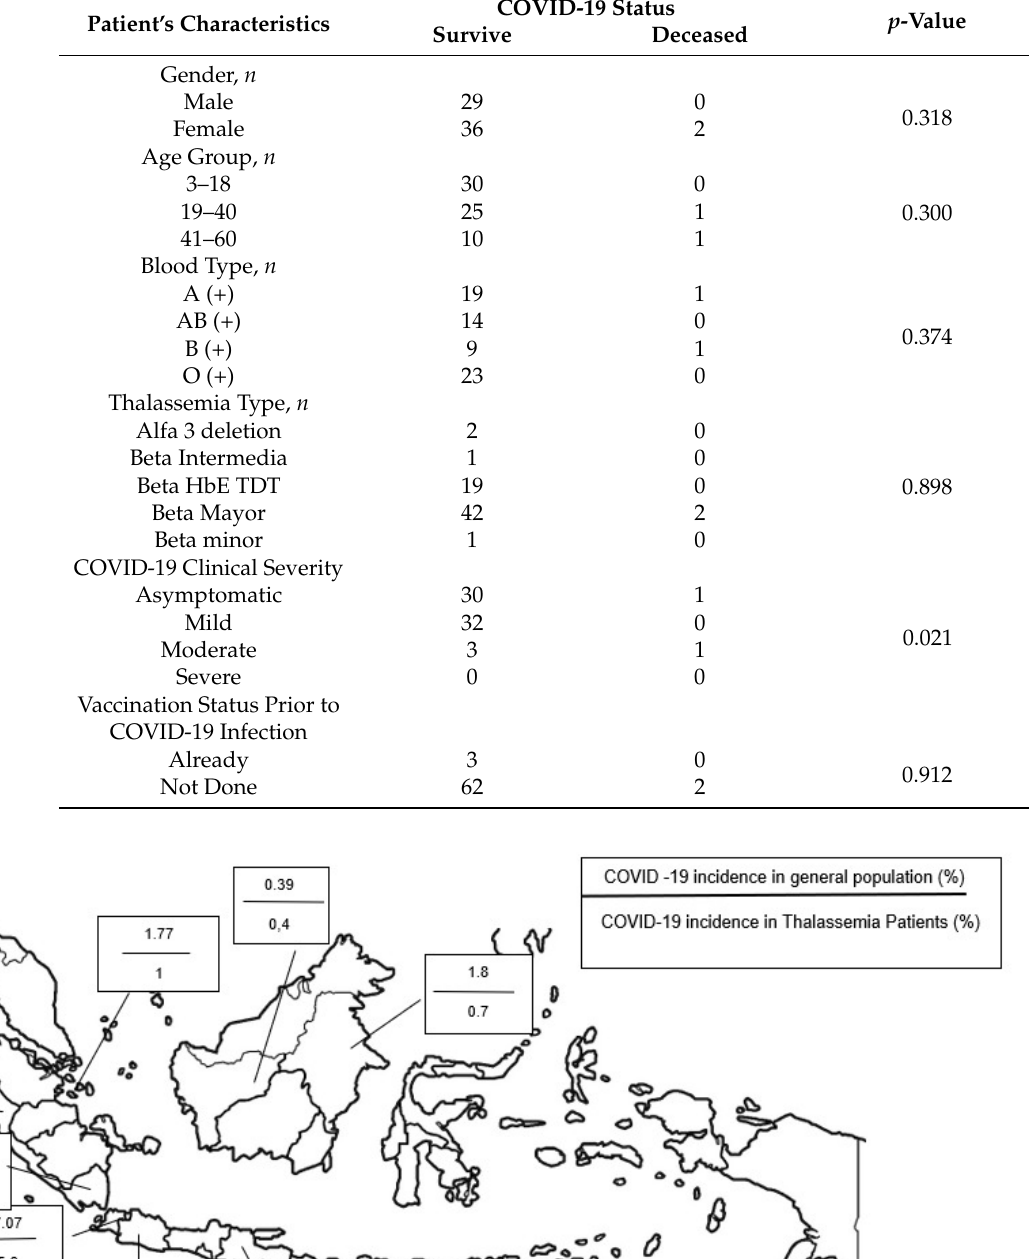
Table 2. Relationship between patient’s characteristics and COVID-19 status.